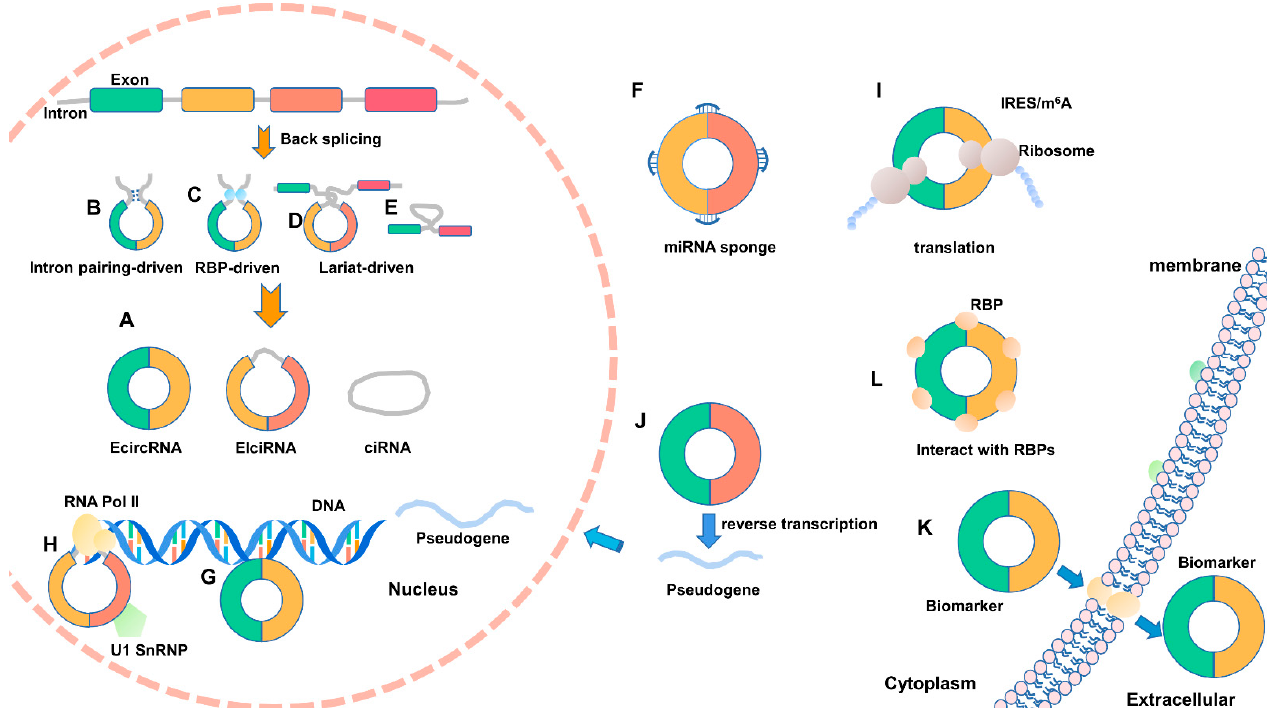
Figure 1. The biogenesis and regulating mechanisms of circular RNA (circRNA). ( A – E ) CircRNAs are formed by back- splicing into three major types of circRNA. ( F – I ) Various regulation mechanisms of circRNAs. ( J ) CircRNA can generate pseudogene by reverse transcription. ( K ) CircRNA can play a role as a biological molecular marker. ( L ) CircRNAs can interact with RBPs. IRES: internal ribosome entry site; m 6 A: N 6 -methyladenosine; U1 snRNP: U1 small nuclear ribonucleoprotein.